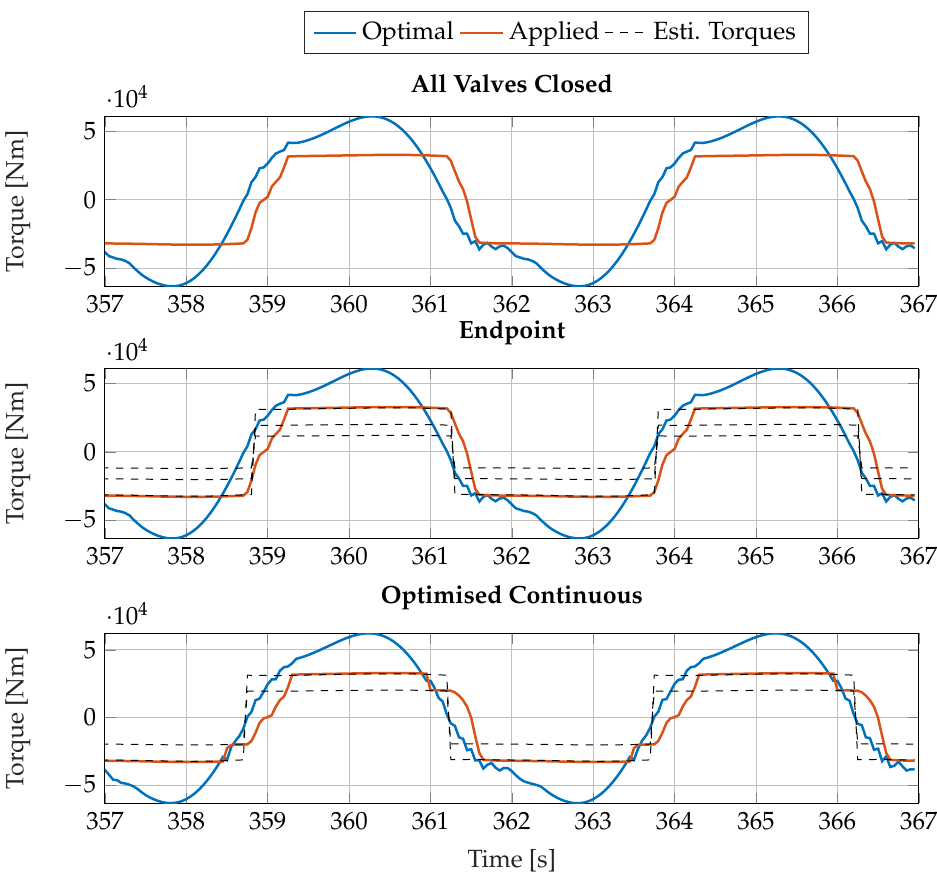
Figure 9. The optimal torque, the applied torque and the estimated possible torques for the three WPEAs at a system pressure of 115 bar during a regular wave with a height of 0.35 m and a period of 5